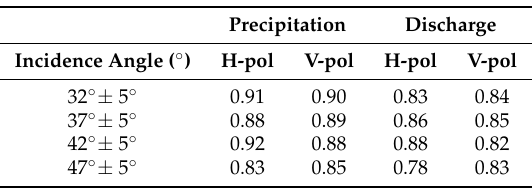
Table 4. Cross-correlation ( r ) values between TRMM precipitation, discharge at the outlet and the SWAF products for the eight configurations over the 2010–2015 period.